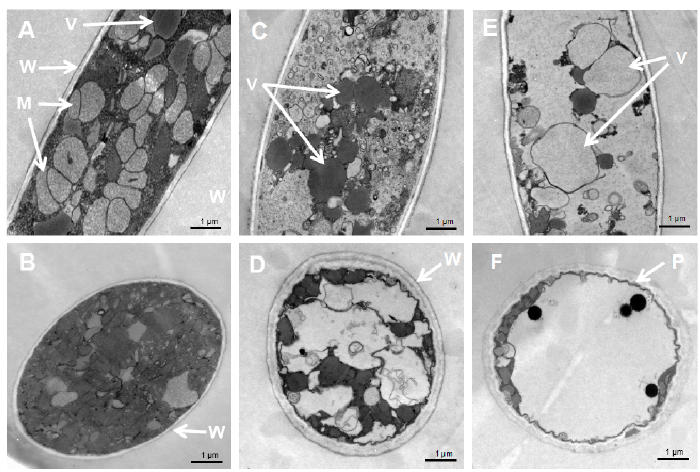
Figure 4. Cellular damages caused by S. fimicarius BWL-H1 volatiles. ( A , B ) untreated control; ( C , D ) mycelial samples fumigated with 40 g/L wheat seed culture of S. fimicarius BWL-H1; ( E , F ) mycelial samples fumigated with 100 g/L wheat seed culture of S. fimicarius BWL-H1. ( A ), ( C ) and ( E ) were longitudinal section through P. litchii hyphae, while ( B , D , F ) were tangential section. M, mitochondria; P, plasma membrane; V, vacuoles; and W, cell wall.